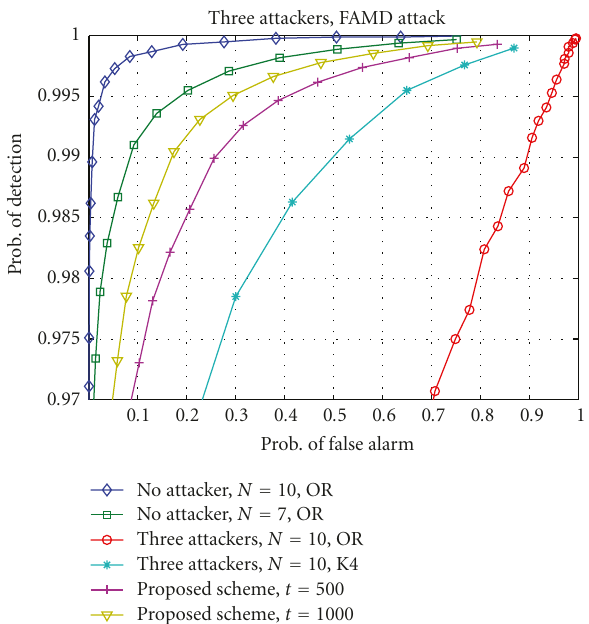
Figure 9: ROC curves (False Alarm & Miss Detection Attack, Three Attackers).